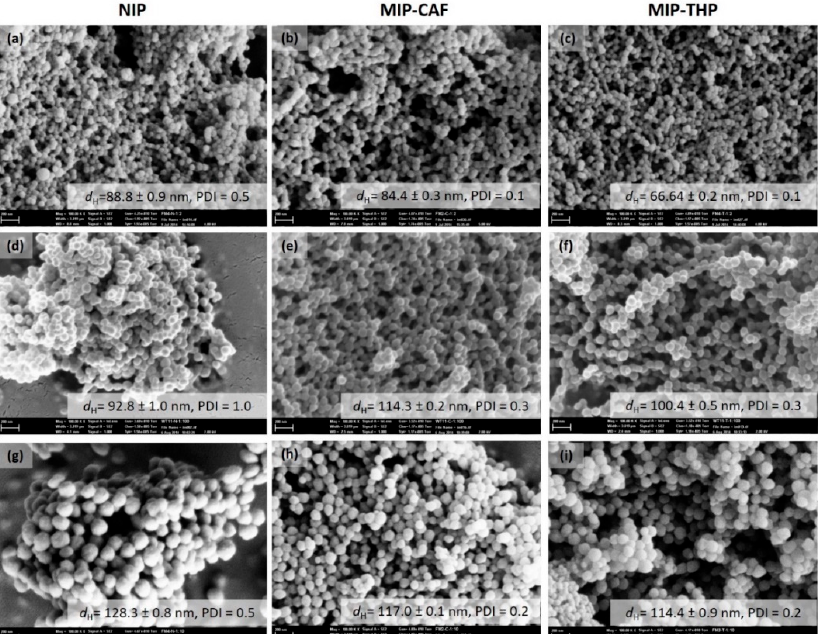
Figure 5. SEM images of polymers synthesized from various fM:X ratios: ( a ) MX2 NIP , ( b ) MX2 CAF , ( c ) MX2 THP , ( d ) MX5 NIP , ( e ) MX5 CAF , ( f ) MX5 THP , ( g ) MX10 NIP , ( h ) MX10 CAF and ( i ) MX10 THP . Scale bar represents 200 µ m at 100,000 × magnification. Insets are the hydrodynamic size of the microspheres with the corresponding polydispersity indexes (PDI) measured by